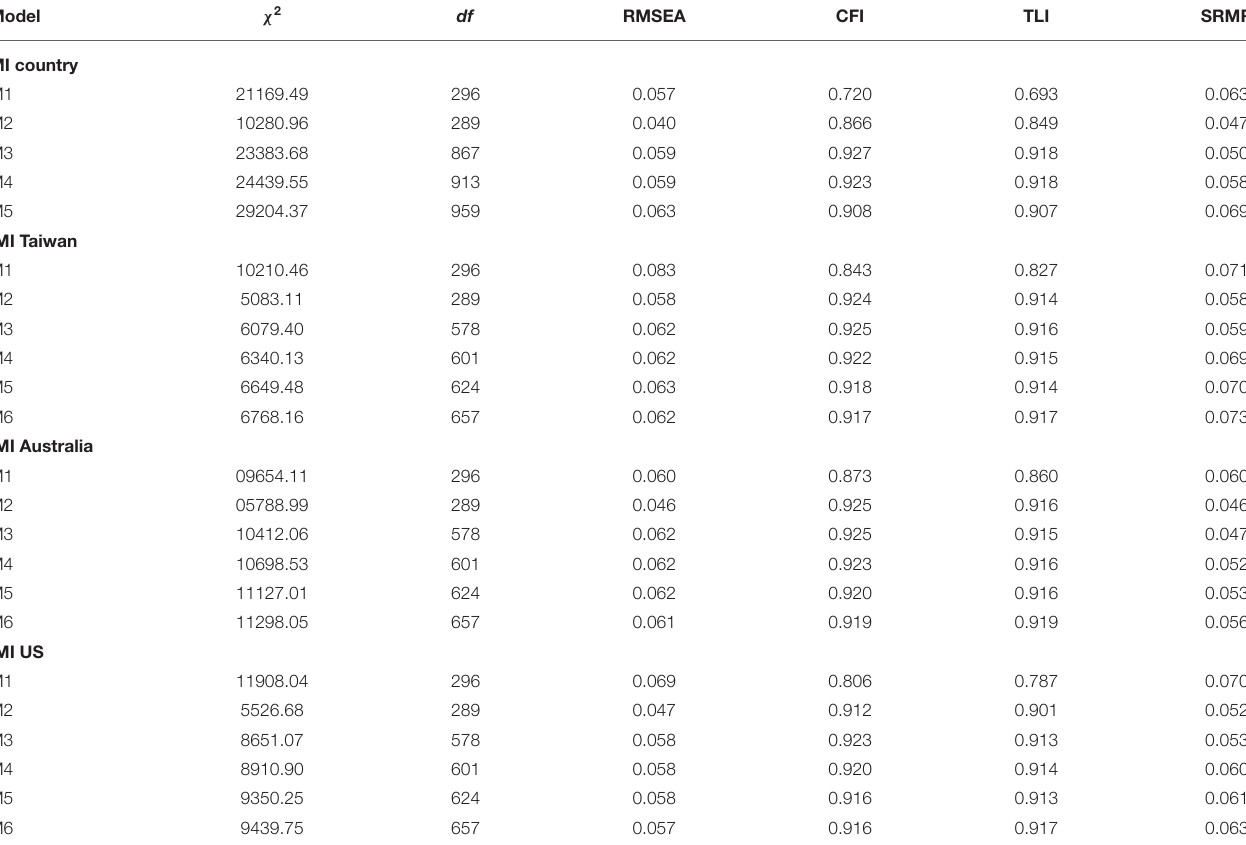
TABLE 2 | The goodness-of-fit statistics for the nested CFA models across countries and genders. Model χ 2 df RMSEA CFI TLI SRMR MI